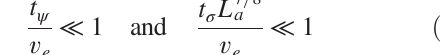
L L FIG. 11. (a) Plot of g ð k [Eq. (48)] versus k , where k e a Þ e a e denotes the incoming emergent-fermion momentum and L is the a length defined in Fig. 10(a). This function determines the t σ correction to the fermion transmission amplitude [Eq. (46)], and thus also the conductance [Eq. (57)], for the interferometer in Fig. 10(a) when a ¼ I or ψ . (b) Magnitude of the scaling functions f (red dashed line) and f (blue line) obtained by iv v inverting Eq. (47) as carried out in Appendix F. These scaling functions govern energy partitioning associated with Ising-anyon tunneling in paths (iv) and (v) summarized in Fig. 10(b) and discussed in Sec. VII A; recall Eq. (44). In the horizontal axis k 1 is the momentum carried by an Ising anyon that tunnels across the constriction. The limiting scaling behavior displayed above implies that Ising anyons tunnel primarily carrying momentum ≪ k and secondarily carrying momentum very near k e e with 1 F 2 a generalized hypergeometric function. Figure 11(a) L L plots g ð k . The perturbative regime stipulated Þ versus k e a e a earlier requires [128] t ψ